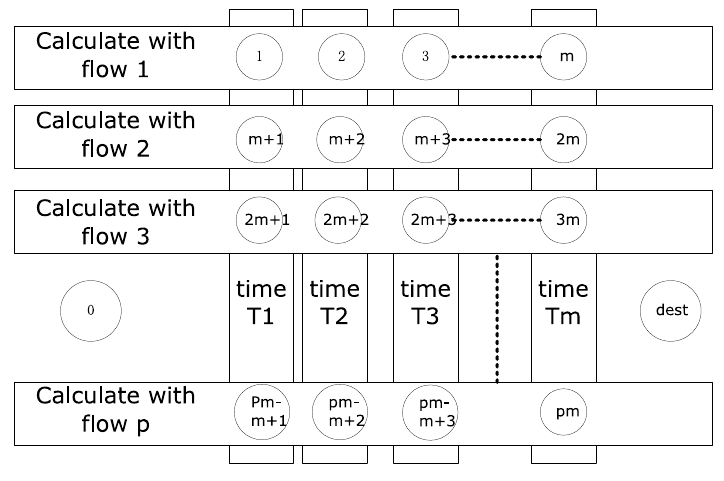
Figure 2. Finding the upper bound of delay.